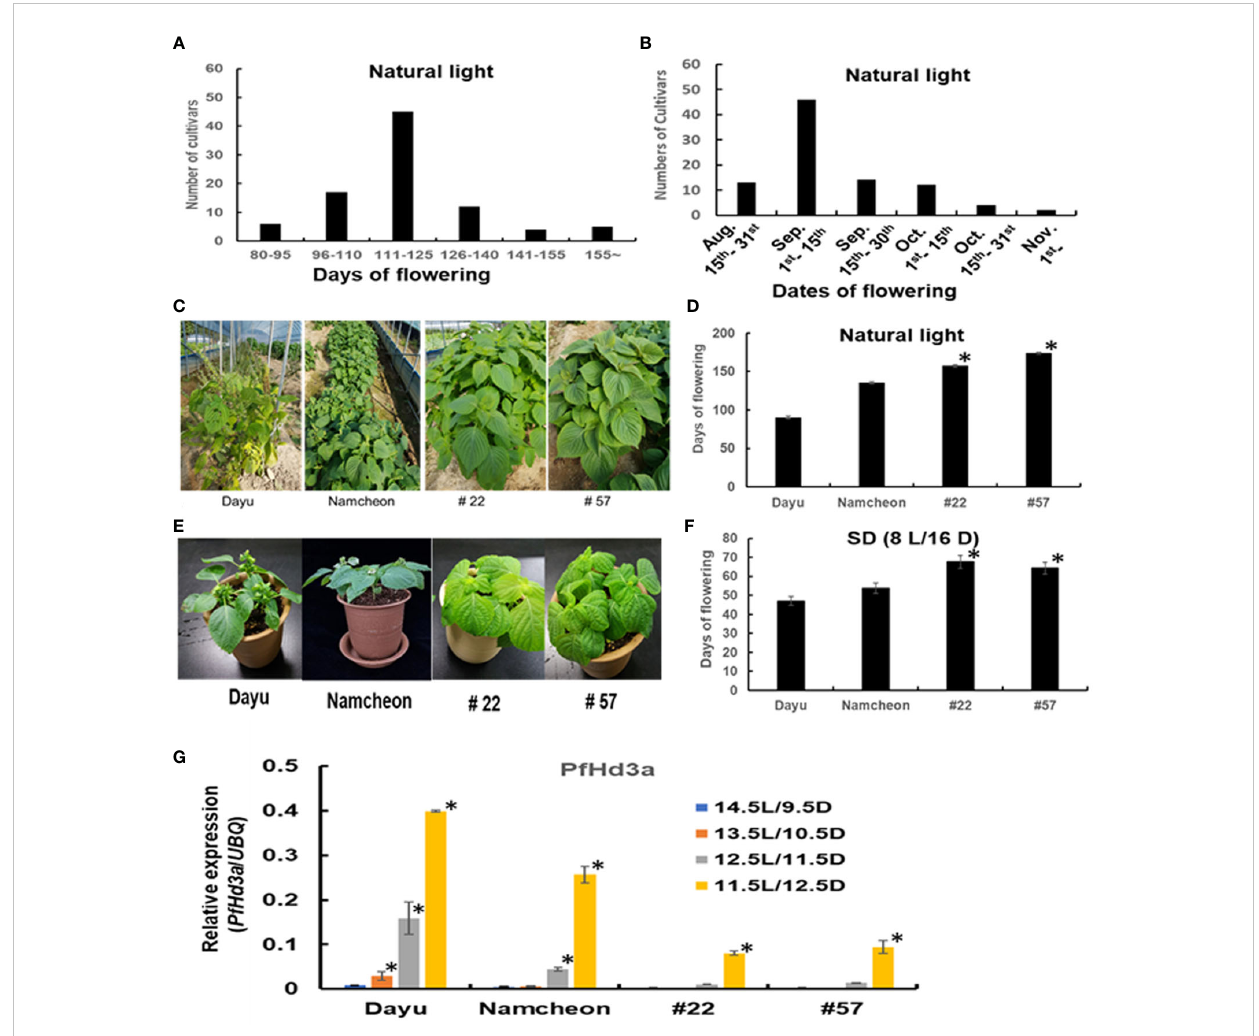
FIGURE 4 Characteristics of 90 perilla cultivars or perilla genetic resources. (A) The data represent frequency distributions of perilla cultivars based on days of fl owering under natural light. (B) The data represent frequency distributions of perilla cultivars based on dates of fl owering under natural light. (C) The fl owering phenotype of seed perilla Dayu, vegetable perilla Namcheon and two perilla genetic resources #22 and #57 under natural light. (D) Flowering days of Dayu, Namcheon, #22, and #57 under natural light. The error bar indicates the standard deviation. Statistical signi fi cance was determined by Student ’ s test (*P < 0.05). (E) Flowering phenotype of Dayu, Namcheon, #22 and #57 under SD (8 h light/16 h darkness) condition. (F) Flowering days of Dayu, Namcheon, #22, and #57 under SD (8 h light/16 h darkness) condition. Statistical signi fi cance was determined by Student ’ s test (*P < 0.05). (G) The transcript levels of PfHd3a in Dayu, Namcheon, #22 and #57 under different light conditions. QRT-PCR was performed with cDNAs with 30-day-old perillas, dayu, namcheon, #22 and #57 grown in different light conditions. Statistical signi fi cance was determined by Student ’ s test (*P <